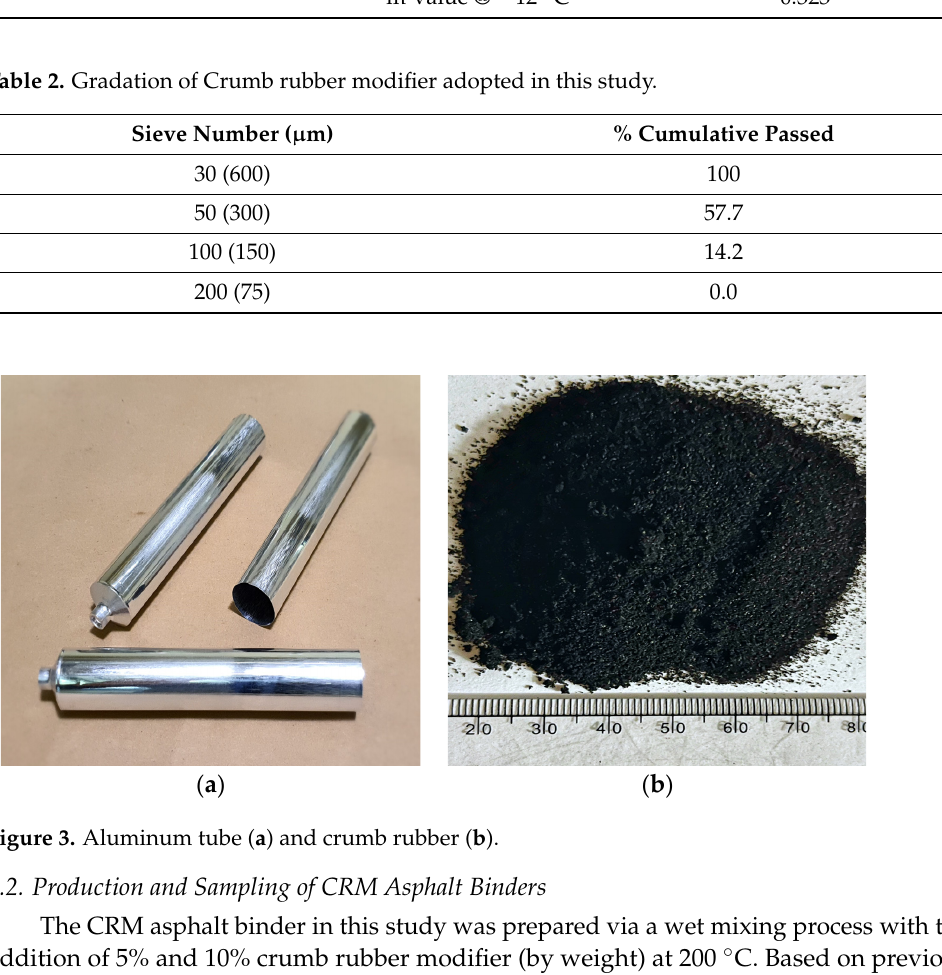
Table 2. Gradation of Crumb rubber modifier adopted in this